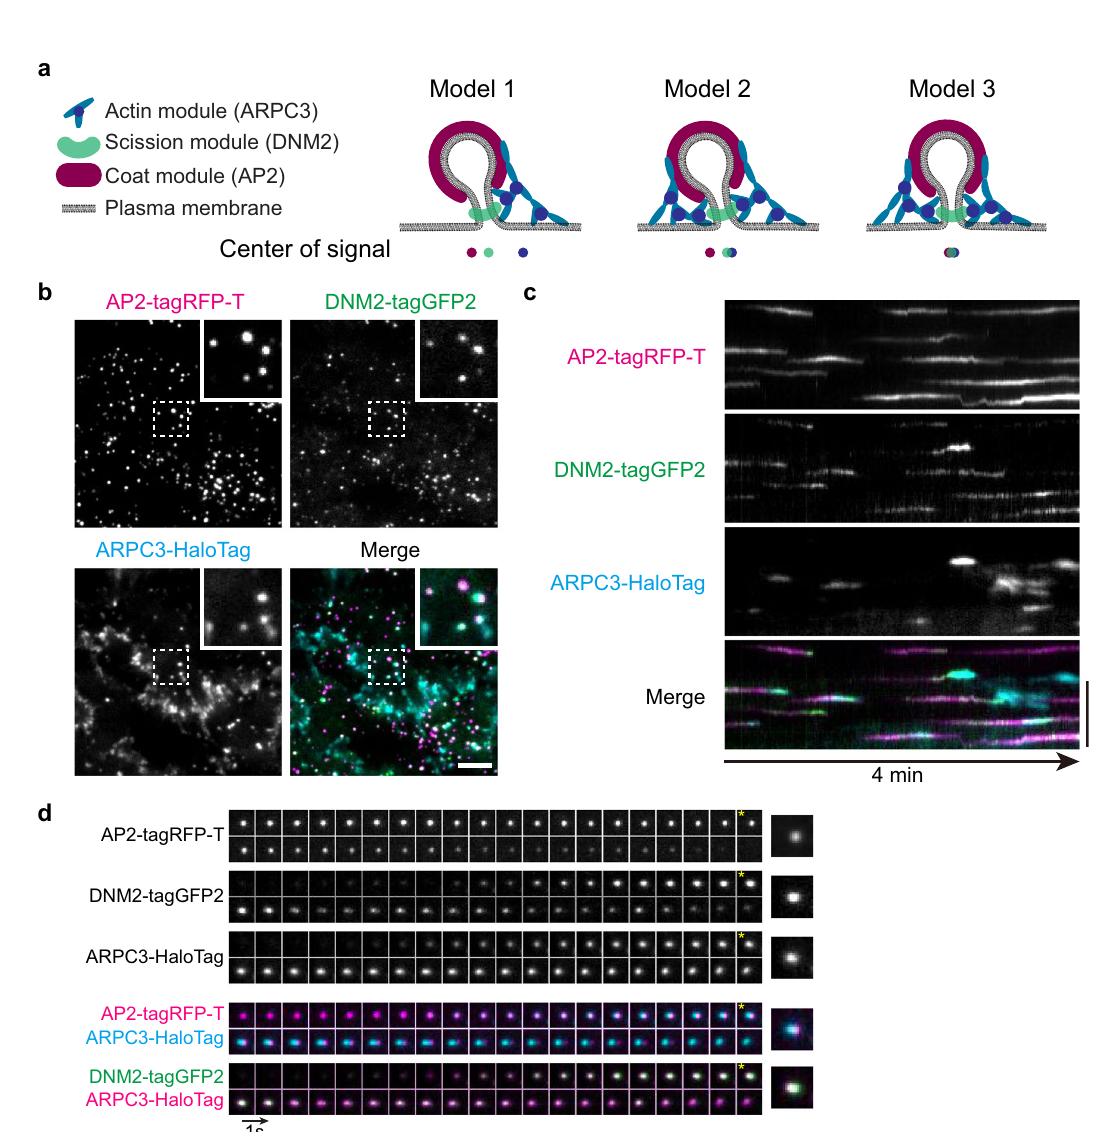
Fig. 1 Two-color, 3D stochastic optical reconstruction microscopy (STORM) shows that actin structures are off-centered with respect to clathrin coats. a , b Two-color 3D STORM image of bottom membrane of ADA cells immunolabeled with clathrin light chain antibody (clathrin, CF-680, magenta) and phalloidin (actin, AF647, rainbow). c A histogram of distances between centroids of clathrin and actin signals. Mean and standard deviation are reported on the graph. Data were analyzed using Prism 9. Source data are provided in the Source Data fi le. d , e Two color 3D STORM image of the bottom membrane of ADA cells immunolabeled with clathrin light chain antibody (clathrin, AF647, magenta) and HaloTag antibody (ARPC3-HaloTag, CF-680, rainbow). Dotted lines label lamellipodia. b , e The highlighted CME sites, which are labeled by white arrows in a , d , are rotated and shown in magni fi ed top and side view projections. Color bar shows the z position of ARPC3-HaloTag. f A histogram of distances between centroids of clathrin and ARPC3 signals. Mean and standard deviation are reported on the graph. Data were analyzed using Prism 9. Source data are provided in the Source Data fi le. Scale bars: a , d : 2 µ m, b , e : 100 nm.